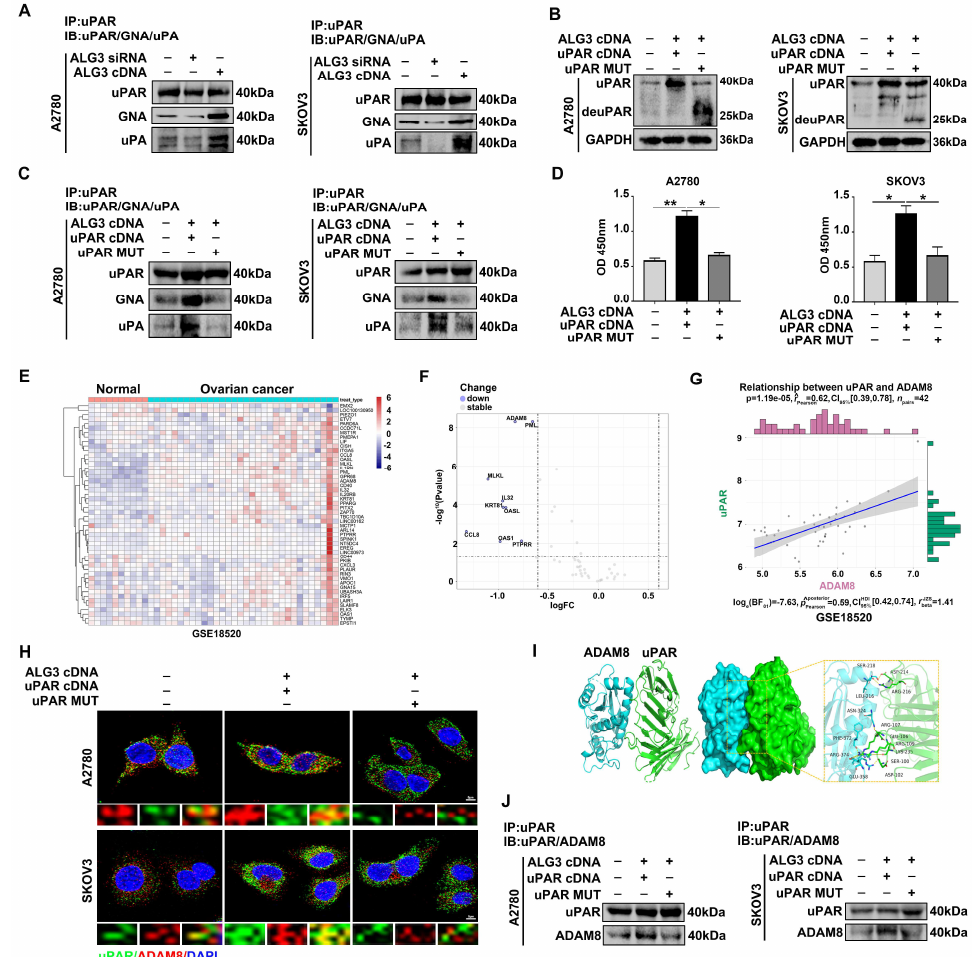
Figure 5. uPAR α 1,3-mannosylation by ALG3 increases its interaction with ADAM8. ( A ) Immuno- precipitated uPAR after ALG3 siRNA and ALG3 cDNA transfection in A2780 and SKOV3 cells detected by GNA and uPA. ( B ) Western blot analysis of uPAR expression after uPAR cDNA and uPAR MUT cDNA transfection in A2780 and SKOV3 cells. ( C ) Anti-uPAR Immunoprecipitations from A2780 and SKOV3 cells co-transfected with ALG3 cDNA and uPAR cDNA or uPAR MUT (mutation) cDNA and blotted with biotinylated GNA and anti-uPA. ( D ) Lectin ELISA detection of glycosylated uPAR was performed in A2780 and SKOV3 cells. ( E ) Heatmap analysis of 50 genes correlated with uPAR in GSE18520. ( F ) Volcano plot of differentially expressed genes between normal ovary and ovarian cancer in GSE18520. ( G ) Correlation analysis of uPAR and ADAM8 in GSE18520. ( H ) Confocal immunofluorescence shows the location of uPAR and ADAM8. The bar represents 5 µ m. ( I ) The binding mode of the complex of ADAM8 with uPAR. Green: uPAR. Bright blue: ADAM8. ( J ) Immunoprecipitation shows the binding ability of uPAR and ADAM8. * p < 0.05, ** p < 0.01.